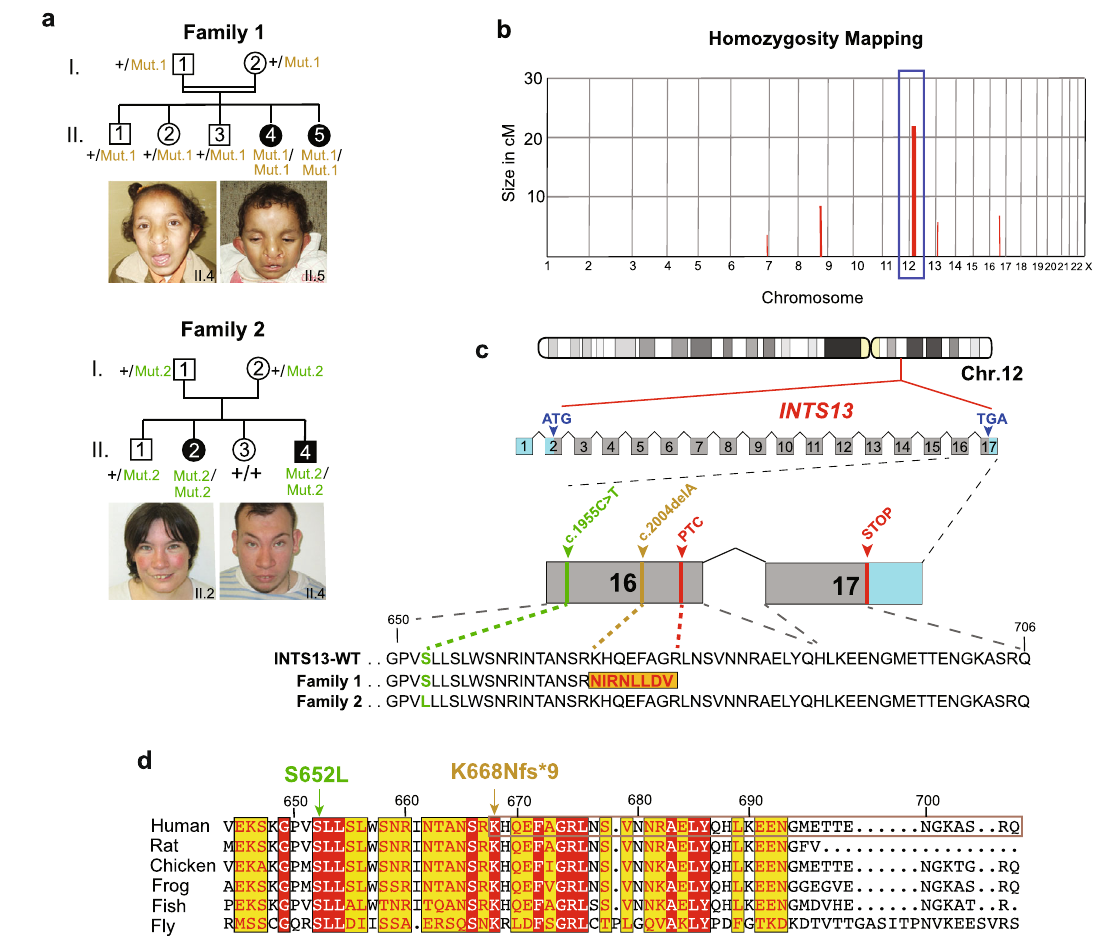
Fig. 1 | Identi fi cation of two families segregating recessive INTS13 variants. a Pedigree of Family 1 (top): affected individuals (II.4 and II.5) were born to fi rst- cousin parents (I.1 and I.2) with three unaffected children (II.1-II.3). Double lines indicate a consanguineous marriage. Pedigree of Family 2 (bottom): affected individuals(II.2andII.4)wereborntoparentswithtwounaffectedchildren(II.1and II.3). b Homozygosity mapping of Family 1 delineated fi ve candidate loci totaling 46cM on chromosomes 6, 8, 12, 13, and 16. c Schematic representation of human INTS13 located on chromosome 12(ch12p13.2-p11.22) consisting of 17 exons. Locus capture followed by massive parallel sequencing identi fi ed a